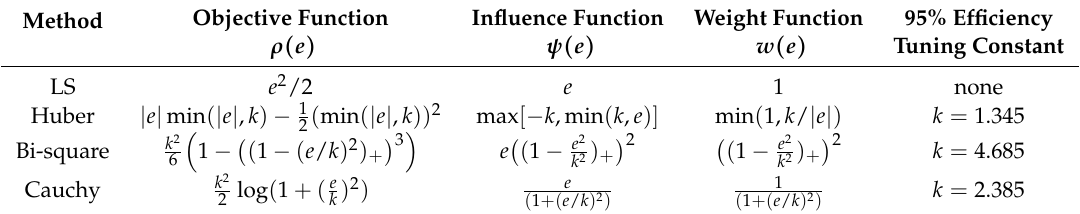
Table 2. Functions ρ ( e ) , ψ ( e ) , and w ( e ) for ordinary least-squares (LS), and three commonly-used robust